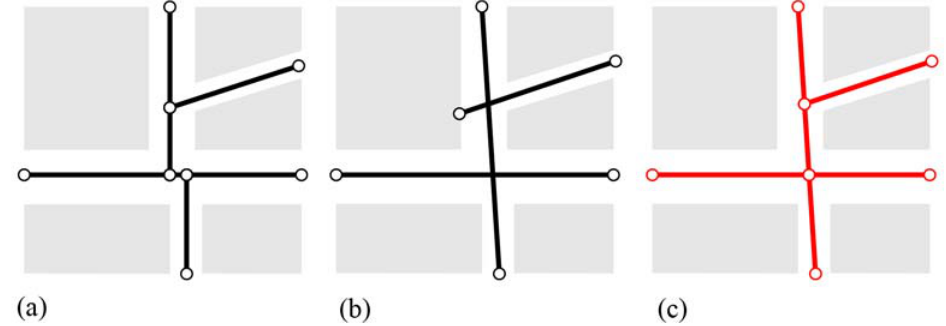
Figure 2. Various street network representations used to represent the street network in the ASA model: ( a ) Street center line; ( b ) Axial map; ( c ) Segment map.